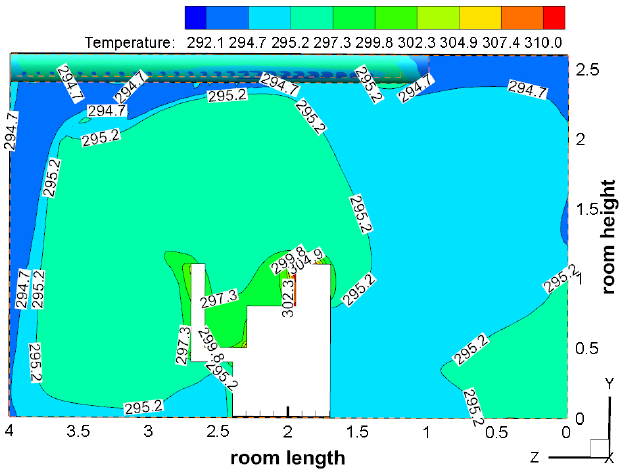
Figure 20. The schematic diagram of the air supply of the split-fiber air conditioner with the air outlet opposite the human body.